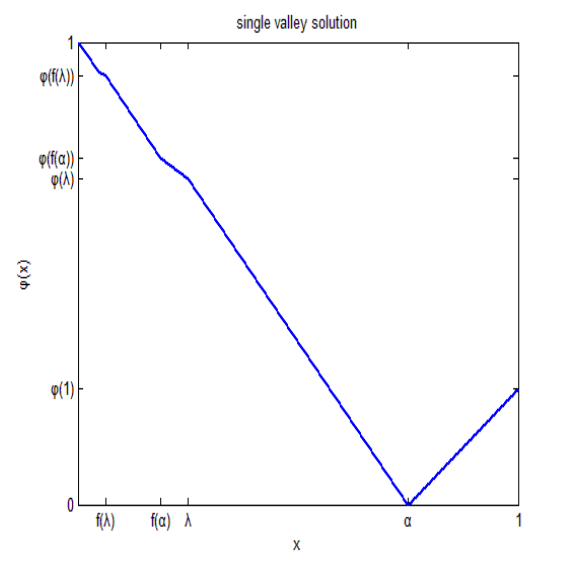
Fig. 2. The graph of single-valley